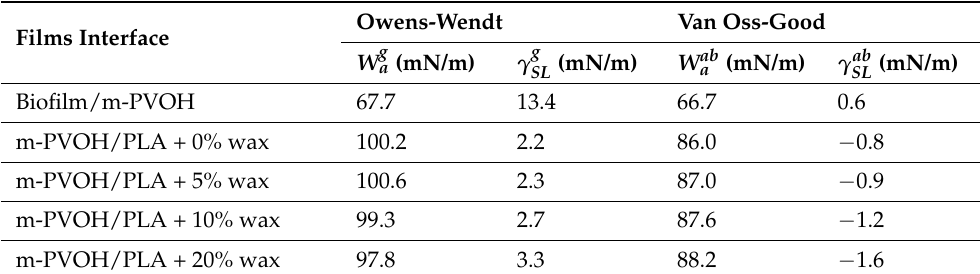
Table 7. Calculated work of adhesion and interfacial energy of the films’ interfaces following both the Owens–Wendt and van Oss–Chaudhury–Good